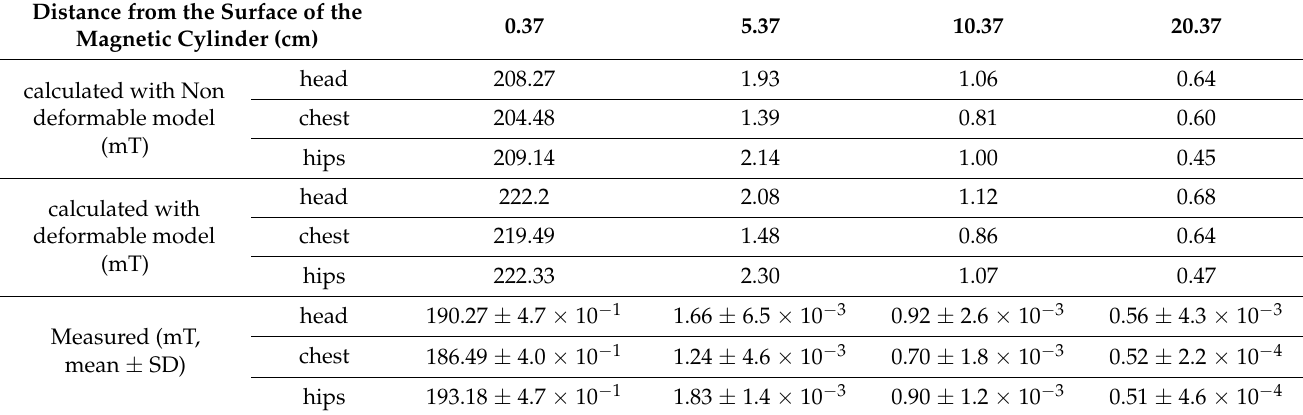
Figure 5. Magnetic field distribution at a distance of 0.37 cm from the surface of the magnetic cylinder with non-deformable model. ( a ): mattress model; ( b ): three-dimensional magnetic field distribution at the level of cotton cover; ( c ): decrease in magnetic flux densities above the surface of cotton cover; ( d ): magnetic field distribution of magnetic strips on the slice of y = 33 cm, ( e ): magnetic field distribution of magnetic cylinders on the slice of y = 30 cm. A coordinate system was established at the corner of the mattress, as shown in Figure 5a. The measured and calculated maximum flux densities values from different location were shown in Table 2. Table 2. The measured and calculated maximum flux